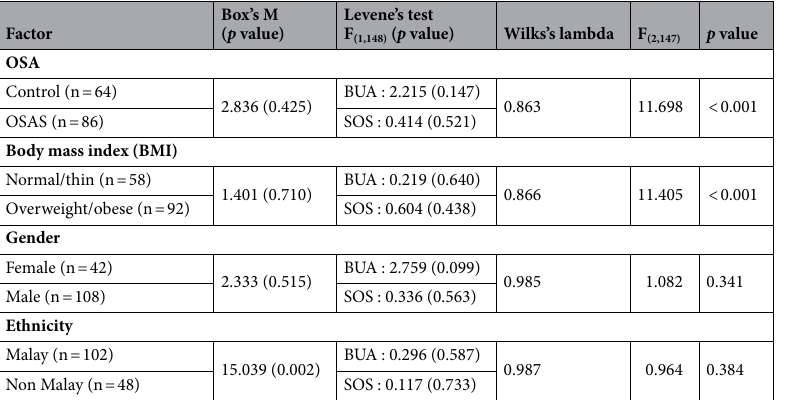
Table 4. Comparison of quantitative ultrasound (BUA and SoS) with demographic factors and OSA (n = 150) by single factor multivariate analysis (MANOVA). Box’s M Box’s test for equivalence of covariance matrices, F F statistic.